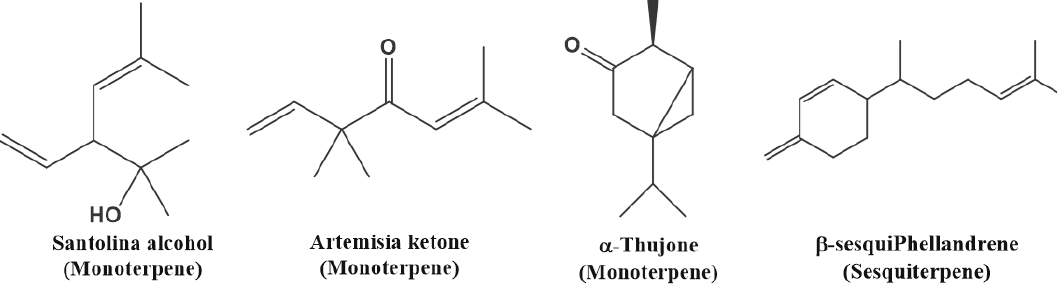
Figure 2. Chemical structure of some components of AFO.